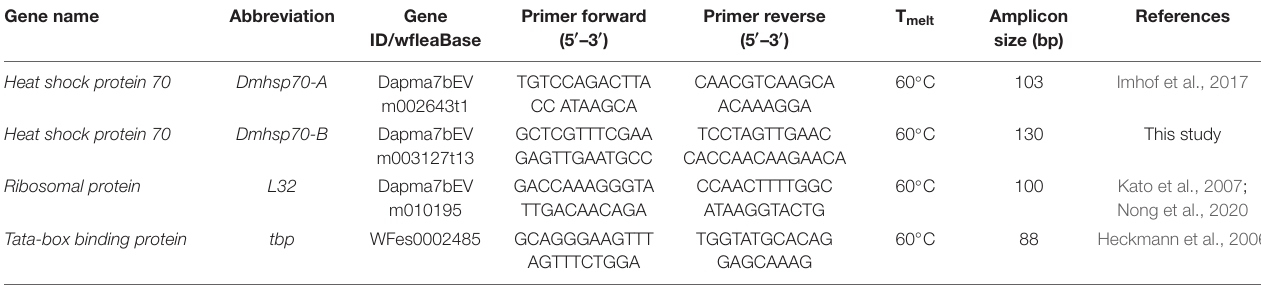
TABLE 2 | qPCR primer pairs used in